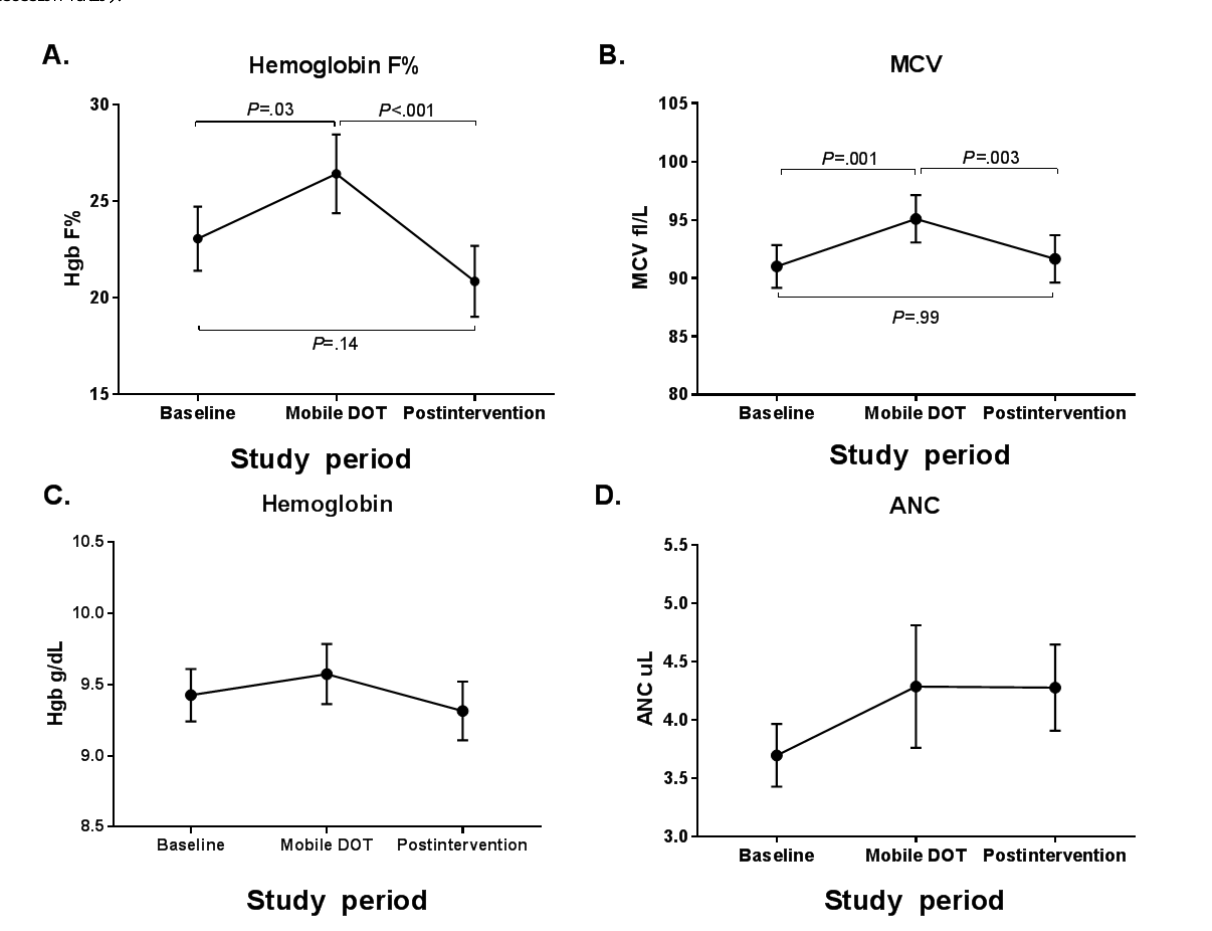
Figure 2. Participants’ hydroxyurea MPR adherence during each study period (Mobile DOT: Mobile Directly Observed Therapy; MPR: medication possession